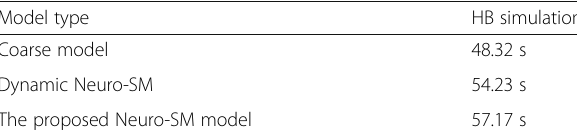
Table 2 Model simulation time comparison between coarse model, dynamic NEURO-SM, and the general Neuro-SM model Model